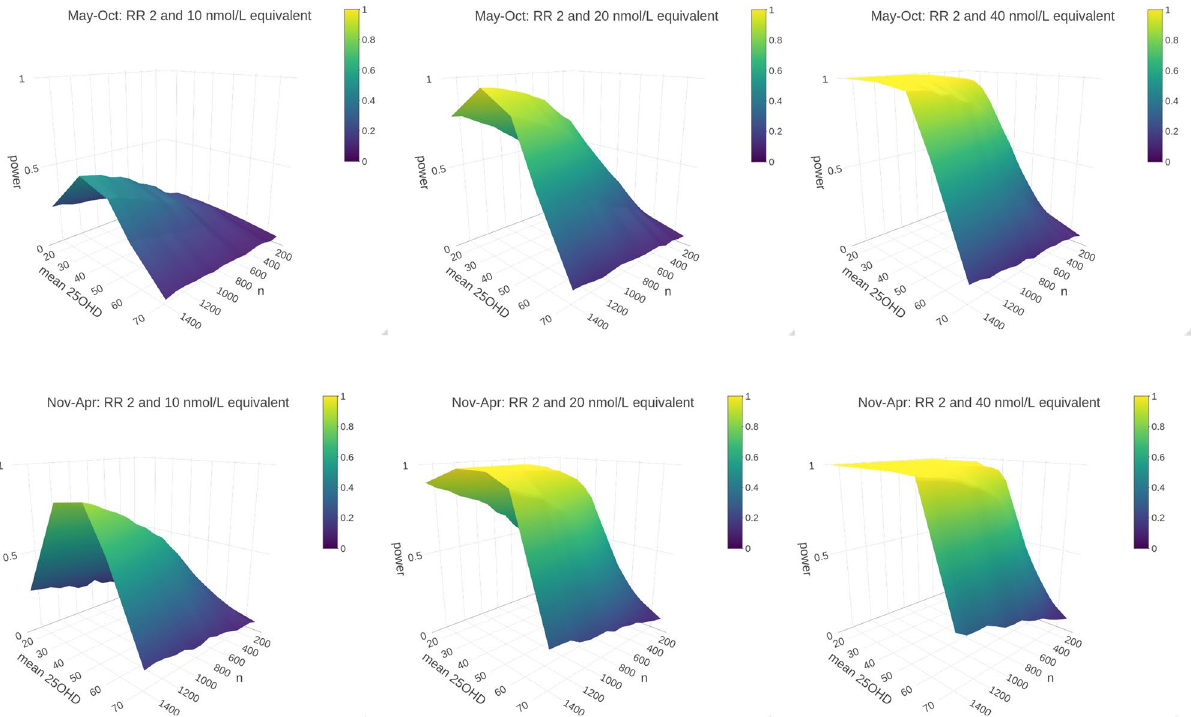
Figure 5. Six month trials. Top row: power surfaces for “summer trial”, running from May until end of October. Bottom row: “winter trial” running from November through April. All experiments assume relative risk between fully depleted and fully replete of 2, u = 2 . n represents the number of participants in each trial arm.